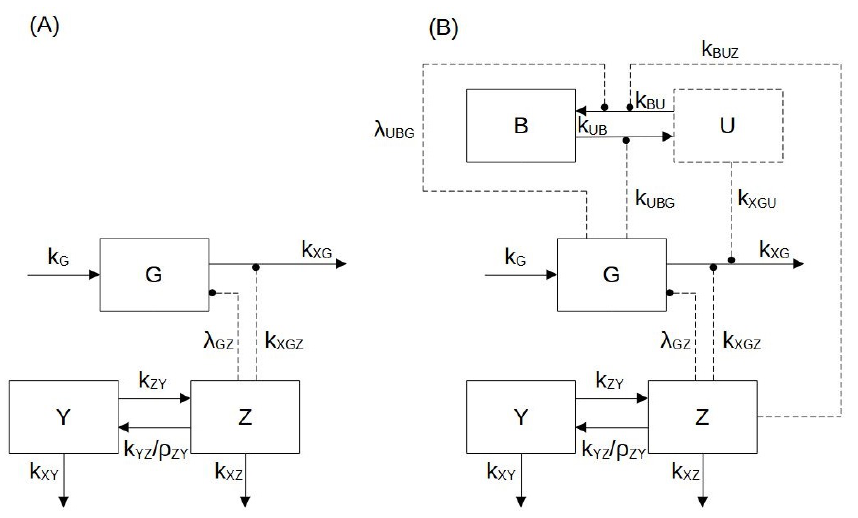
Figure 1. Block diagram of Model 1 (panel A ) and Model 2 (panel B ). According to the mathematical formulation used for two models, the biological variables considered are: the zoledronate concentra- tion in the medium (Y( µ M)); the zoledronic acid (ZA) intracellular concentration (Z (pmol/mg prot)); the antigen (IPP) concentration (G (pmol/(mg prot))); the percentage of bound enzyme (B (%)) and the percentage of unbound enzyme (U (%)). Blocks with a continuous contour represent differential variables (Z, Y, G, B), and the block with a dashed contour represents the algebraic variable (U). Arrows in continuous lines indicate mass transfer, while dashed arrows indicate enhancement (arrow endpoints) or suppression (circle